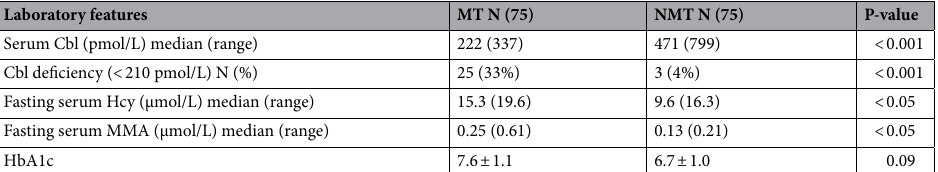
Table 2. Comparison of laboratory features for metformin-treated and non-metformin-treated groups. MT: metformin-treated, NMT: non-metformin-treated, Cbl: cobalamin, Hcy: homocysteine, MMA: methylmalonic acid, N: number, HbA1c: hemoglobin